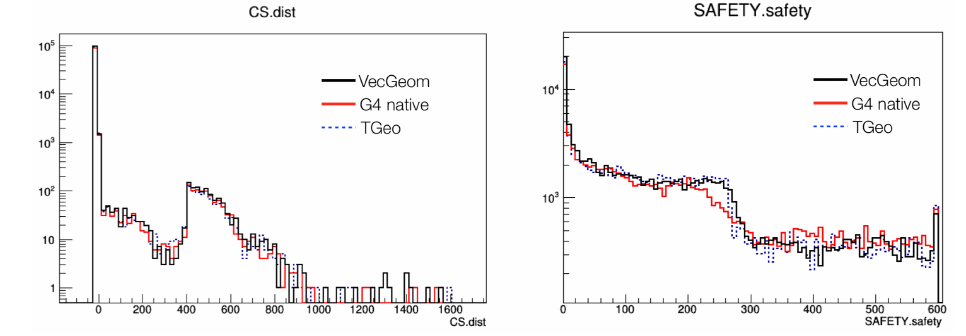
Figure 4. Distribution of step (left) and safety values (right) in mm returned to the Geant4 transport engine from the Geant4, TGeo and the new VecGeom navigator implementation. The simulation was asked to process a number of simple events in the test geometry with 600 sensors. All distributions are fully consistent and agree in the total number of entries and their form. Note that the curves for safety do not need to overlap strictly because safety may be